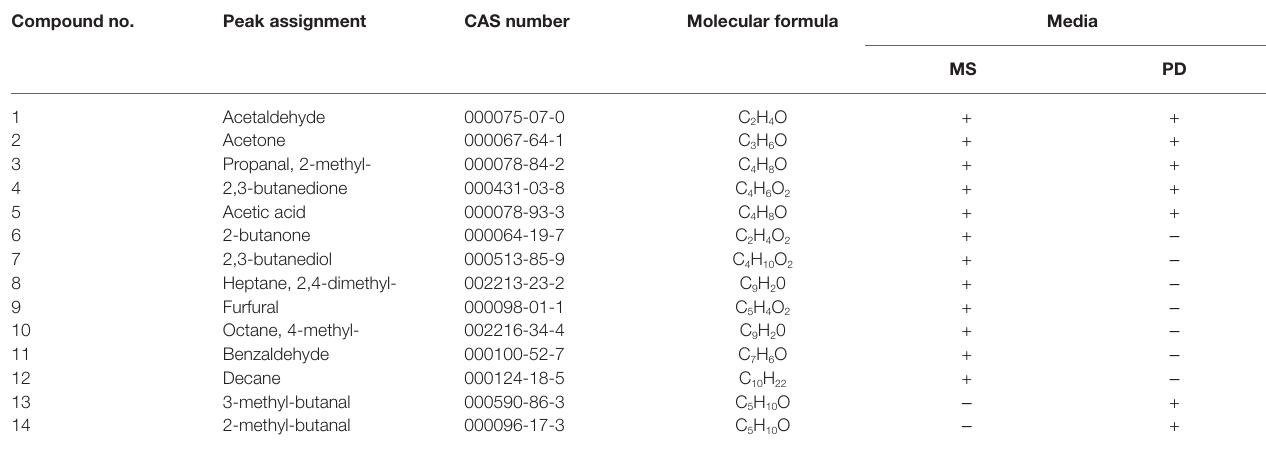
TABLE 1 | Identification of volatile organic compounds produced by C. halotolerans NGPF1 grown on two different media. Compound